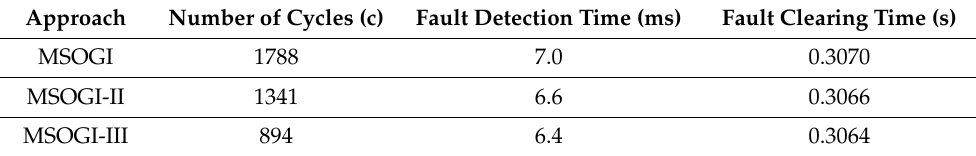
Table 5. Fault detection and clearing times of the three MSOGI approaches with a 3PH-G fault at F3 and the number of cycles required to compute it. Approach Number of Cycles (c) Fault Detection Time (ms) Fault Clearing Time (s) MSOGI 1788 7.0 0.3070 MSOGI-II 1341 6.6 0.3066 MSOGI-III 894 6.4